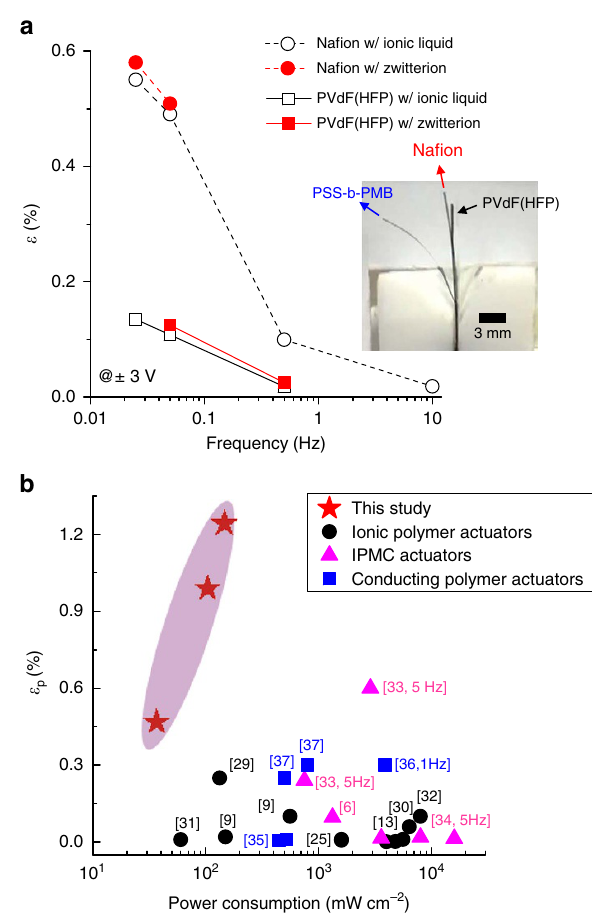
Figure 4 | Low-power and high-performance actuators. ( a ) Strain- frequency dependency of the actuators based on PVdF(HFP) and Nafion containing ZImS and Im/TFSI, measured with alternating square-wave voltages of ± 3V. Photographs in the inset were taken at (cid:2) 3V and 0.5Hz to directly compare the actuation performance of the actuator to that of actuators based on conventional polymers. ( b ) Strain-power consumption dependency of the actuator, compared with other types of soft actuators reported thus far, which clearly represents the impact of our results on the structure of widely studied actuators fabricated with polymeric